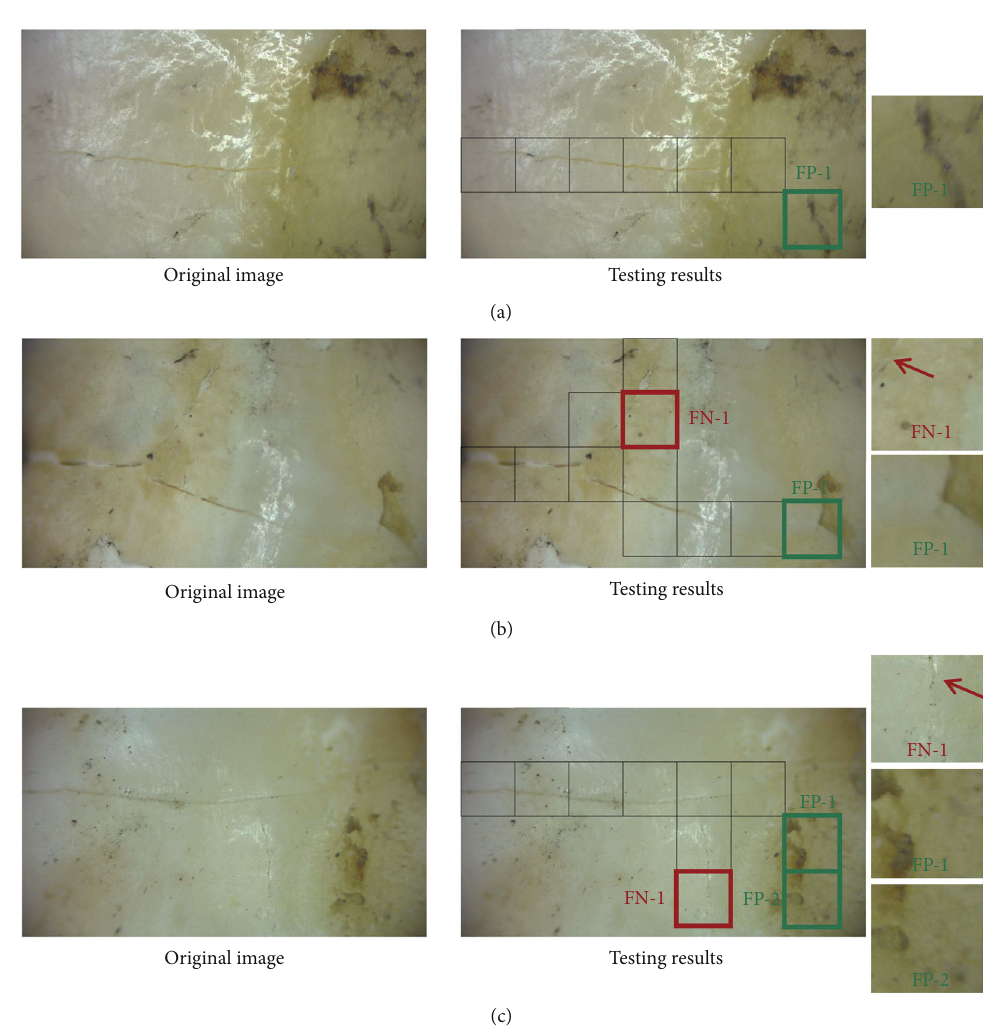
Figure 11: Testing results for image containing stained tooth surfaces of di ff erent types of cracks: (a) normal cracks; (b) normal crossed cracks; and (c) normal cracks and tiny cracks. The red arrows point to the